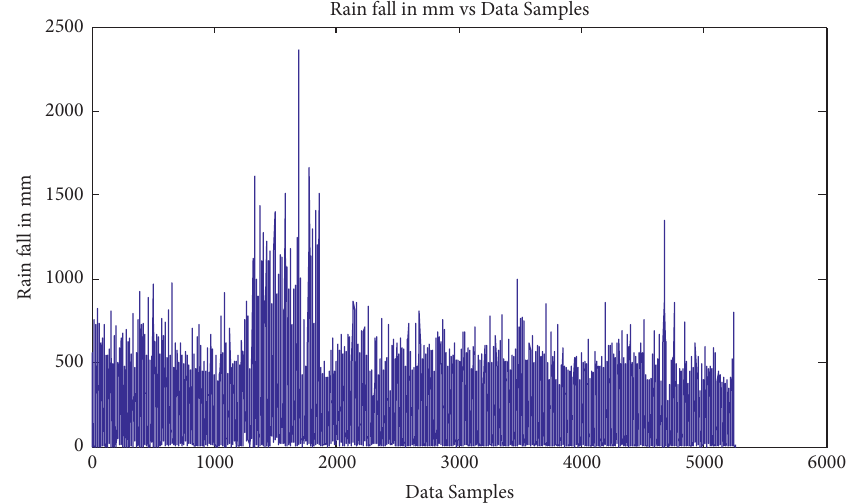
Figure 10: Rainfall in mm vs. data samples.